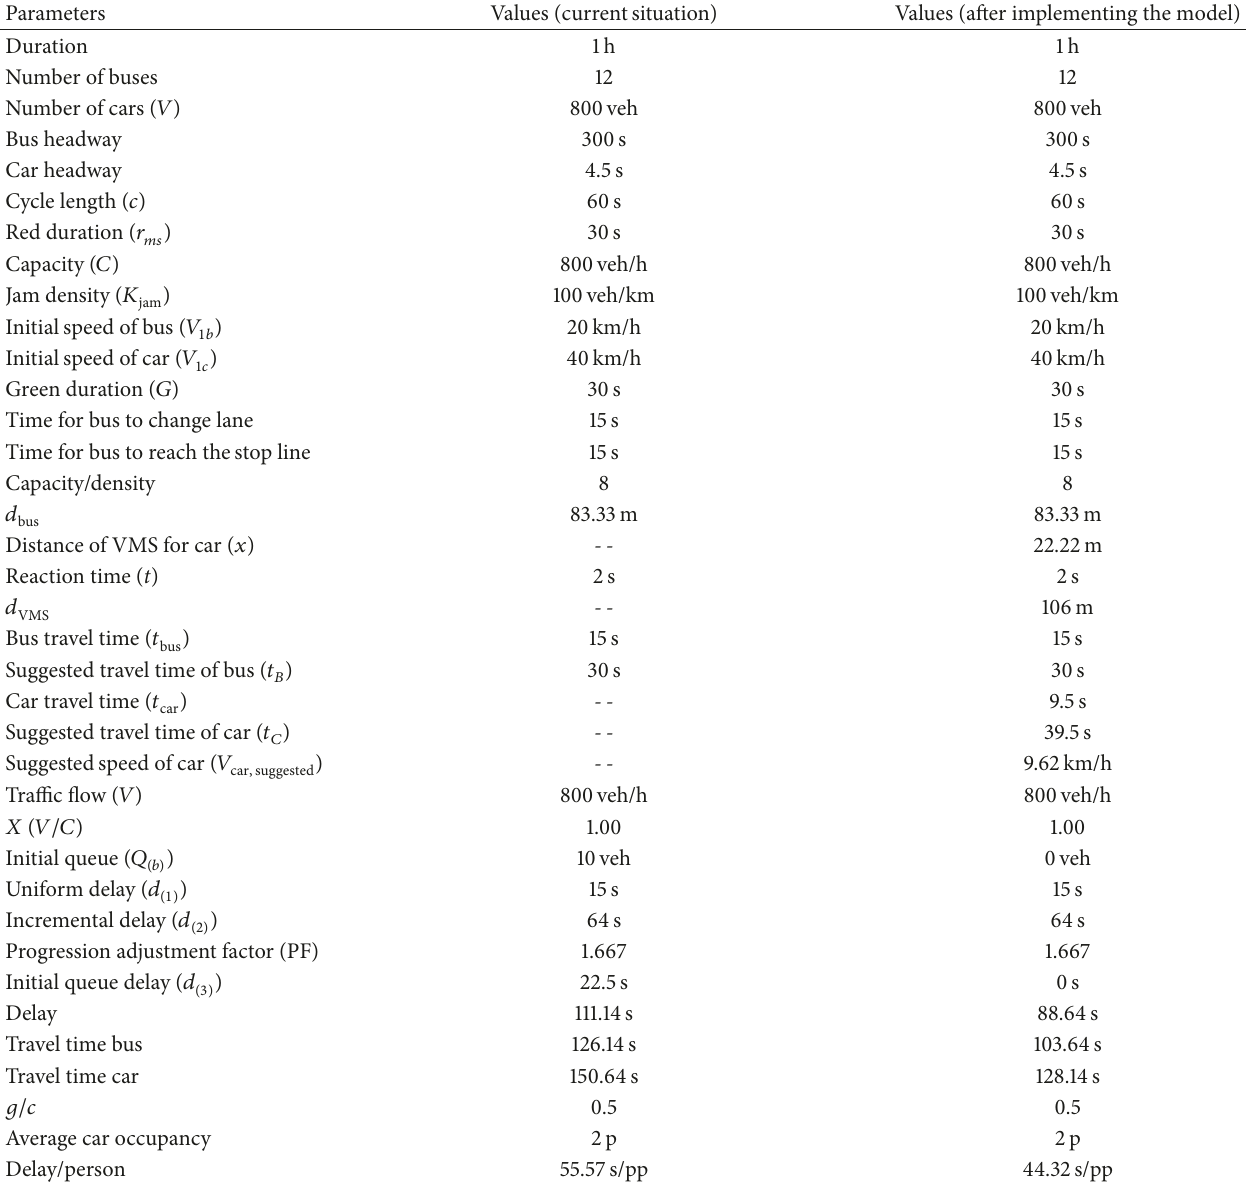
Table 1: Assumptions for parameters used in the